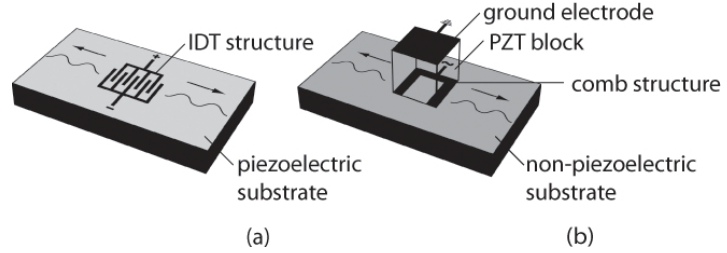
Figure 2. (a) Interdigital transducer on a piezoelectric substrate. (b) Single-phase transducer on a non-piezoelectric substrate.